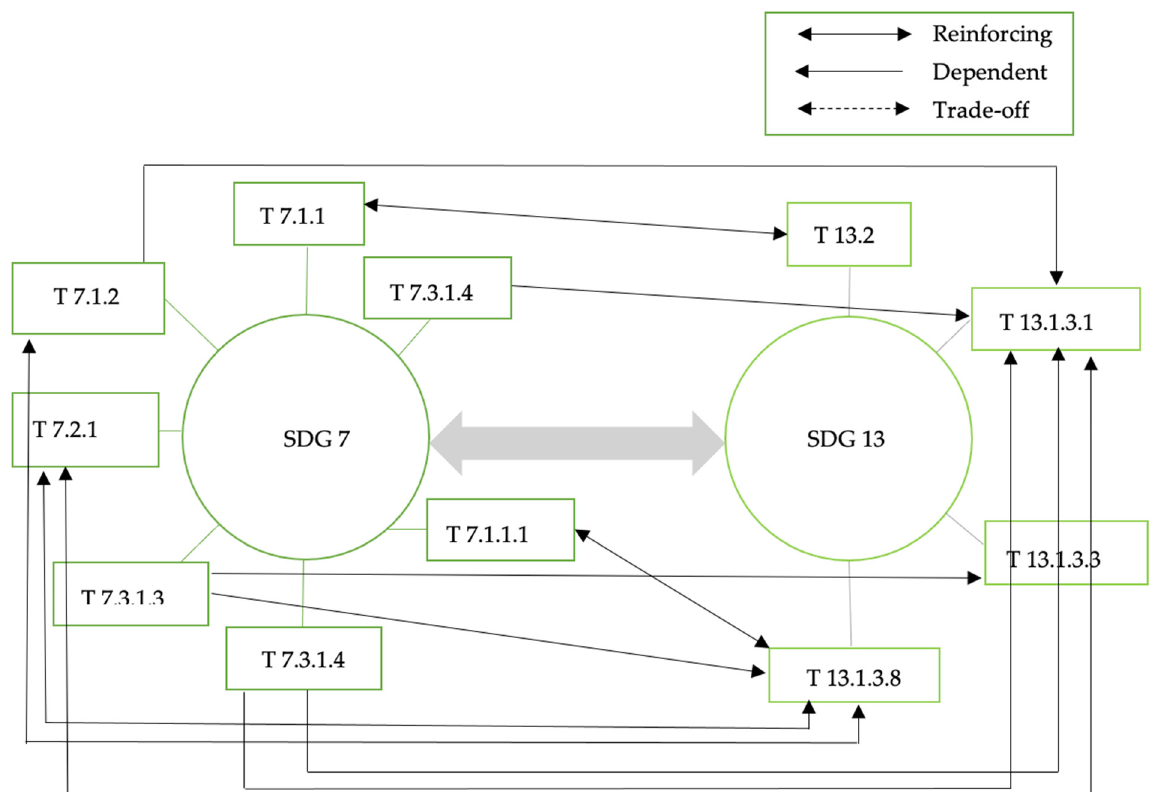
Figure 5. A conceptual linkage between SDG 7 with SDG 13.